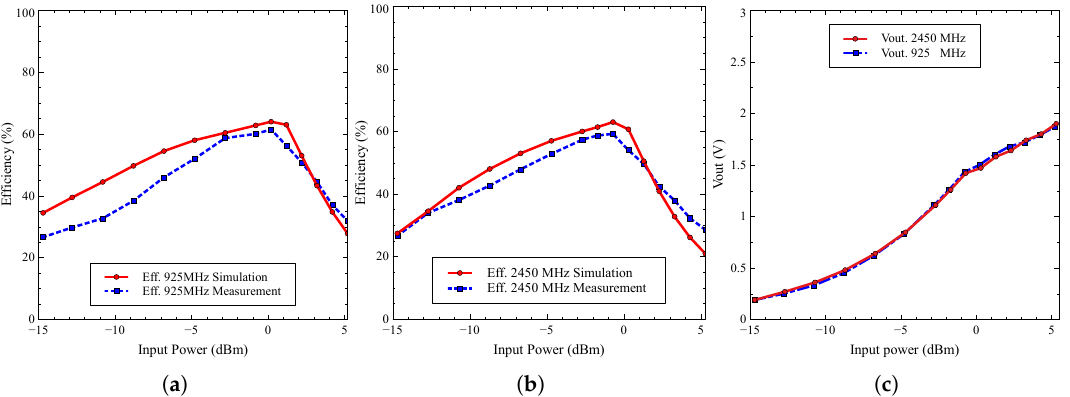
Figure 15. Efficiency at ( a ) low-frequency band, ( b ) high-frequency band and ( c ) output voltage of the rectifier.